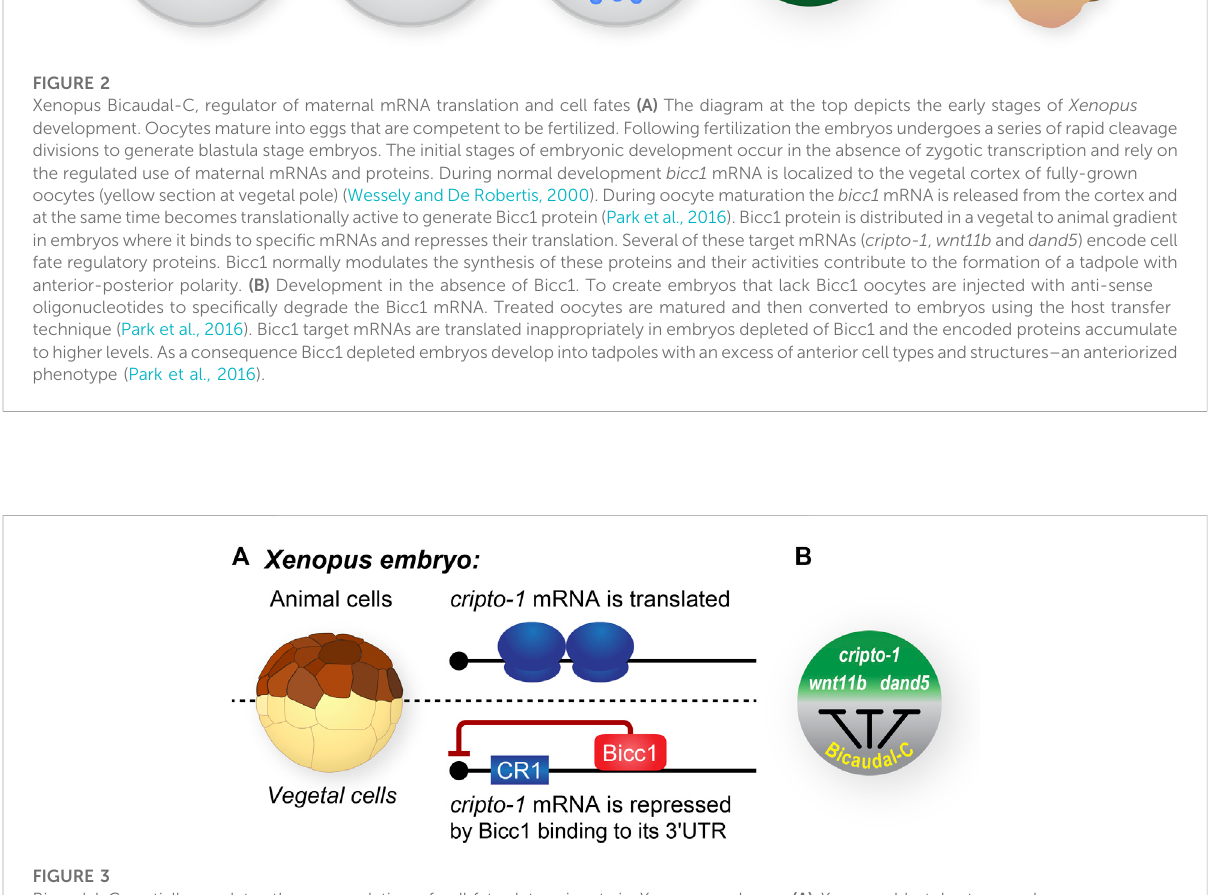
Frontiers in Cell and Developmental